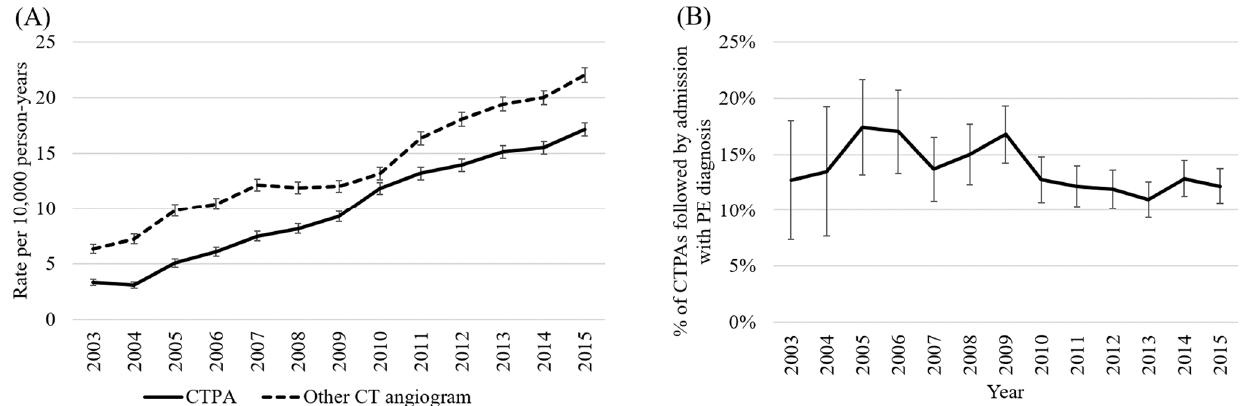
Figure 1. ( A ) Rates of CTPA and other CT angiography; ( B ) Diagnostic yield of emergency department CTPA. Legend: Rates of CTPA and other CT angiography adjusted for age and sex. Other CT angiography in part A excludes records relating to stent work-ups and a subset of thoracic aorta and head scans with apparent coding changes during the study period. Diagnostic yield (part B) reflects the adjusted % of CTPAs performed during an unplanned ED presentation that were followed by admission with PE as the primary/secondary diagnosis. Model adjusted for sex, socio-economic status, remoteness, triage code, arrival type, and referral source. Abbreviations: CTPA, computed tomography pulmonary angiography; ED, emergency department; PE, pulmonary embolism.